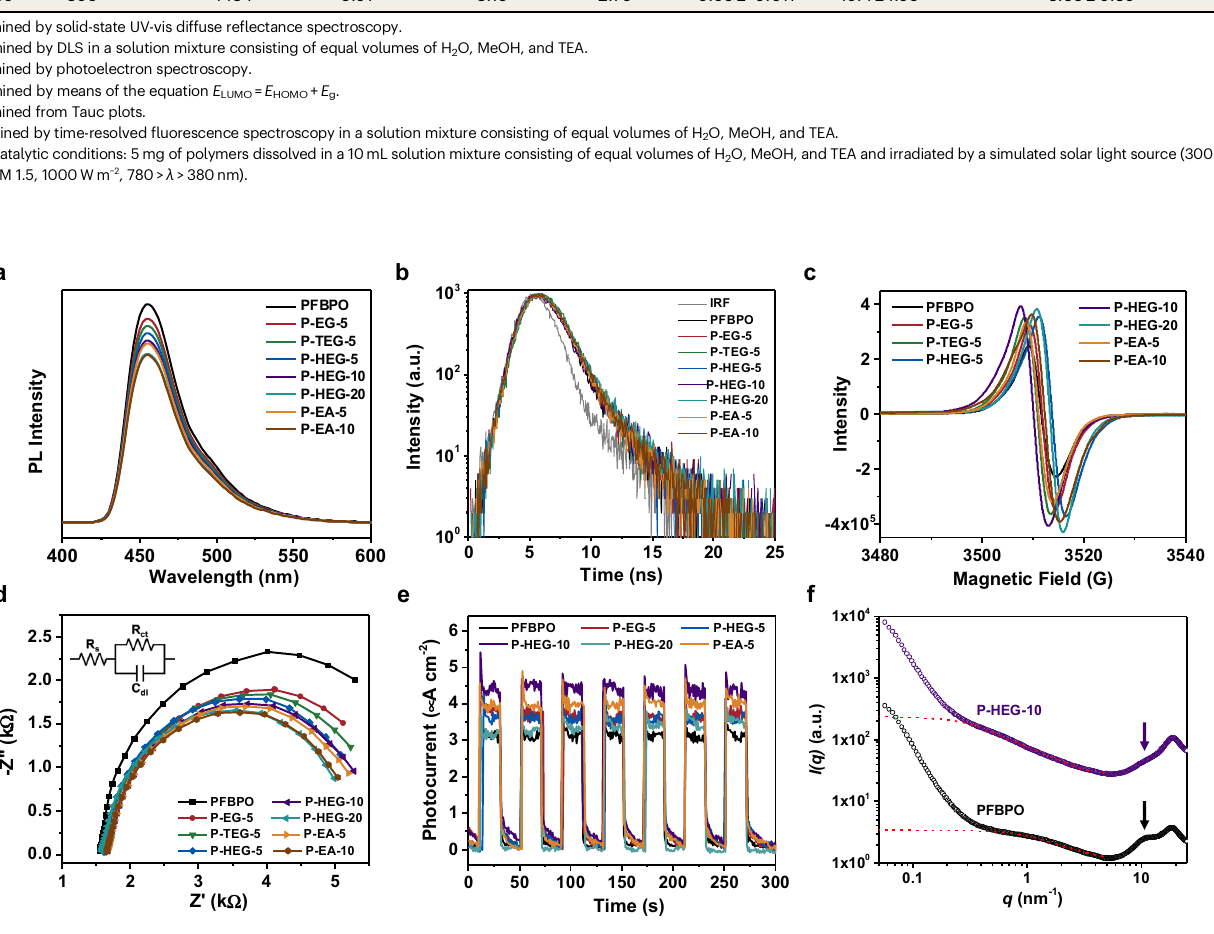
Fig. 3 | Optical and electrochemical properties of polymers. a Photoluminescence spectrawereobtained insuspensions (5mgphotocatalyst in 10mL solution mixture consisting of equal volumes of H 2 O, MeOH, and TEA). b Time-resolved photoluminescence spectra were obtained in suspensions (5mg photocatalyst in 10mL solution mixture consisting of equal volumes of H 2 O, MeOH, and TEA). Samples were excited with a 405nm laser and emission was measuredat455nm. c EPRspectrawerecollectedinthesolidstateunderadditional light illumination. d Electrochemical impedance spectra of polymers were